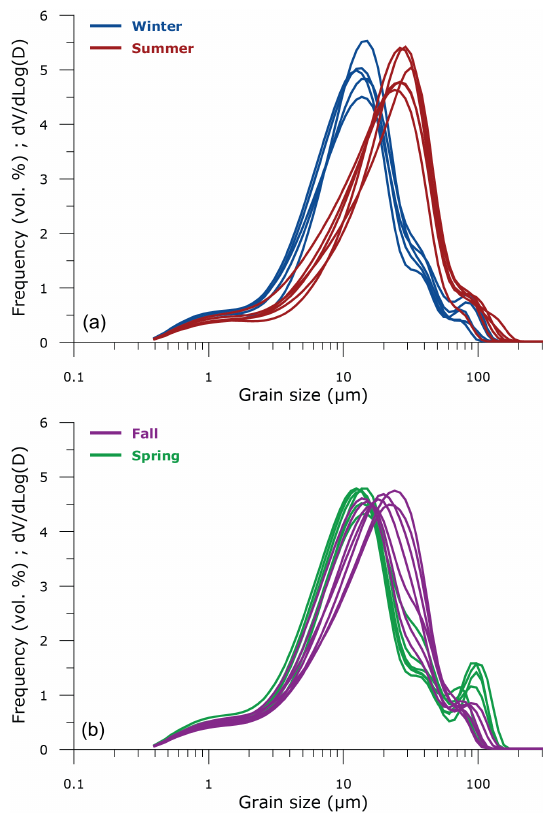
Figure 6. Seasonal grain-size distributions at station M1 (12 ◦ N, 23 ◦ W; approximately 700km from the African coast) for October 2012–November 2013. (a) Winter (blue) and summer (red). (b) Fall (purple) and spring